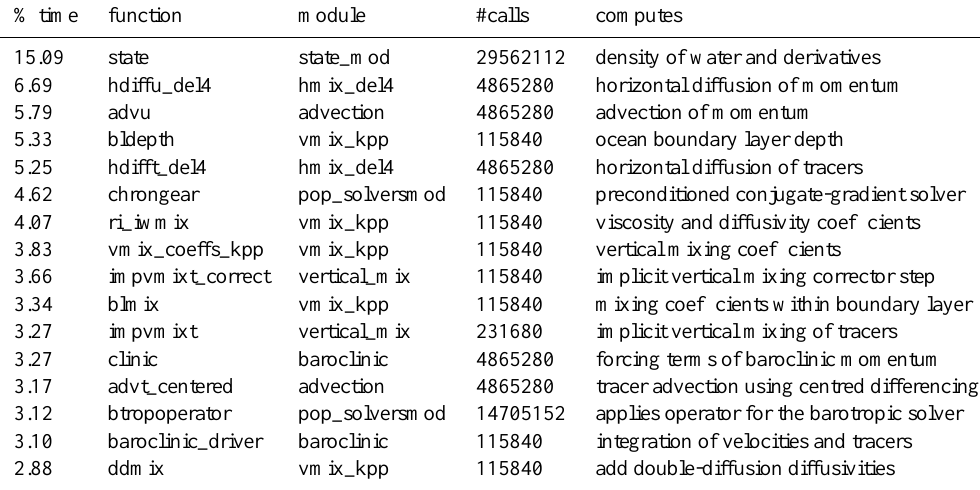
Table 4. List of the most compute-intensive functions in POP, covering 76.48% of the total computation time. The reported time does not include time spent in functions called by this